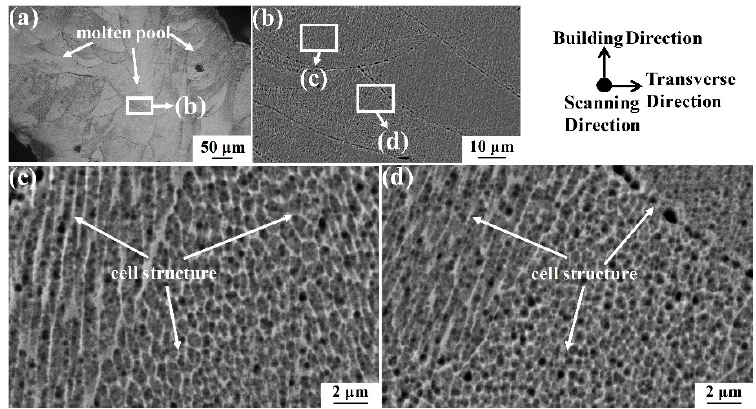
Figure 6. ( a ) Optical micrograph and ( b ) SEM micrograph of the 316L stainless steel Type I lattice structure fabricated via SLM revealing the morphology of molten pool. ( c , d ) SEM micrographs showing the observed cell structure can be formed at the boundary of the molten pool and other areas. Two kinds of substructures consist of cell structures: Strip-like substructures and spherical substructures.